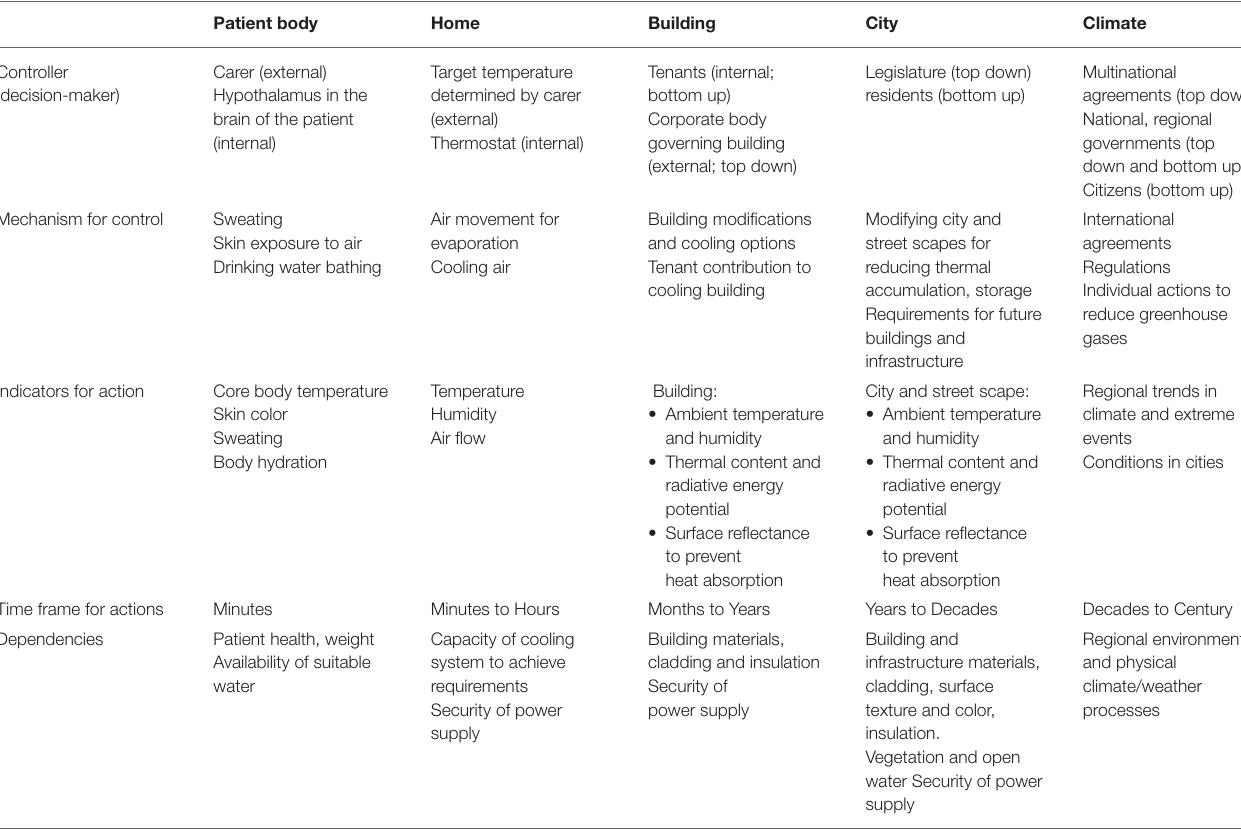
TABLE 1 | Example Attributes of the nested-control systems influencing the risk of an elderly patient experiencing a heat stroke during home care (lists are not